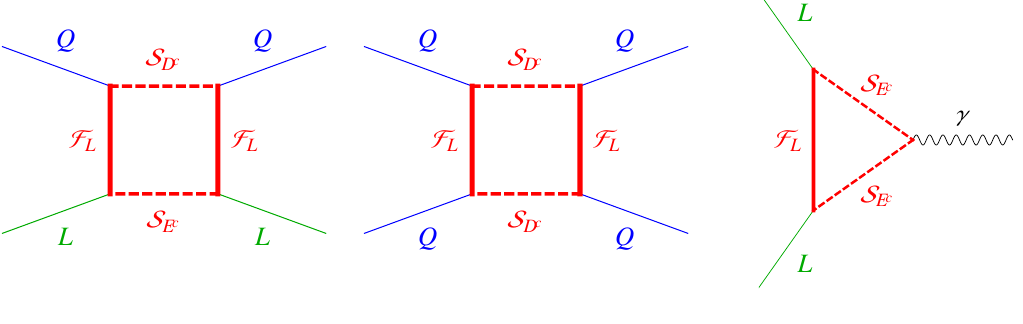
Figure 7 . Feynman diagrams contributing to R K , (cid:1) M B fermions and extra scalars . In Fundamental Composite Higgs models these diagrams will be F S dressed by further new composite dynamic